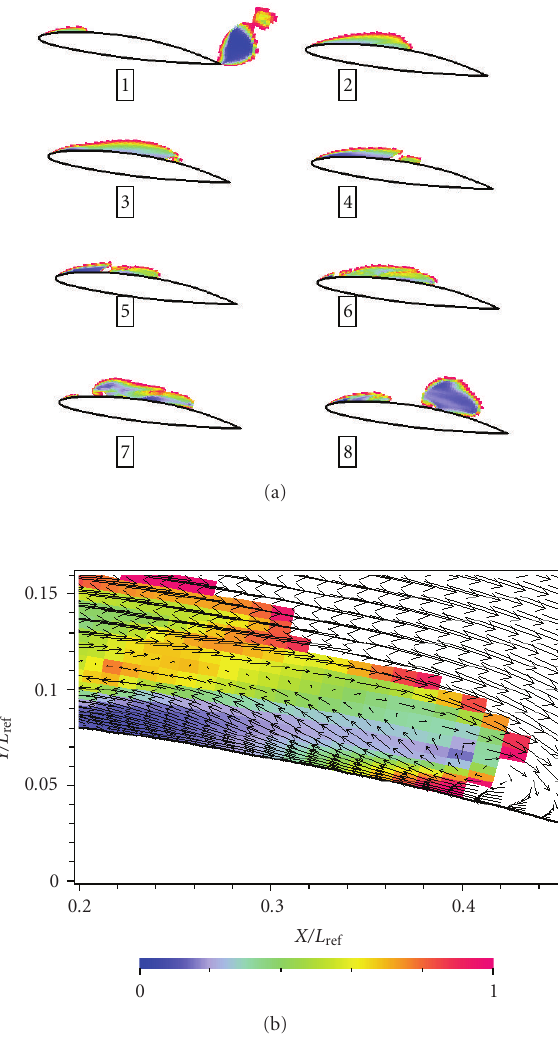
Figure 6: (a) Time evolution of the cavity shape during a single cycle of vapor shedding. The colors indicate the fluid density, white for pure liquid and from red to blue when the void ratio increases. (b) Velocity field and fluid density during cavity breako ff show a reentrant jet (picture 6 in